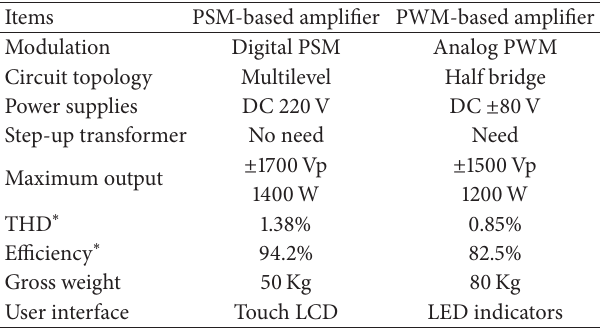
Table 3: Comparisons of two power amplifier